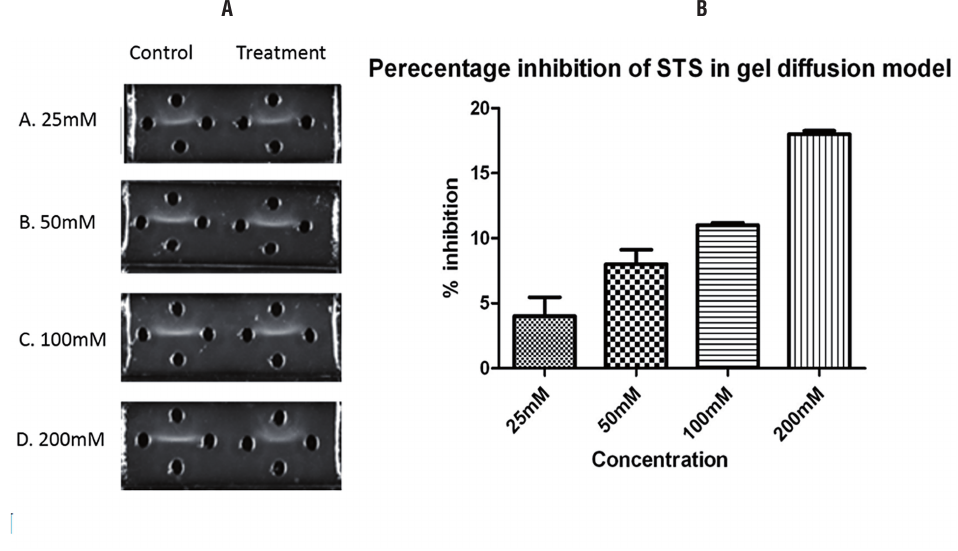
figure 2 - Images of agar gel slides and graph representing the percentage inhibition produced by sTs in calcium oxalate crystal formation represented as a